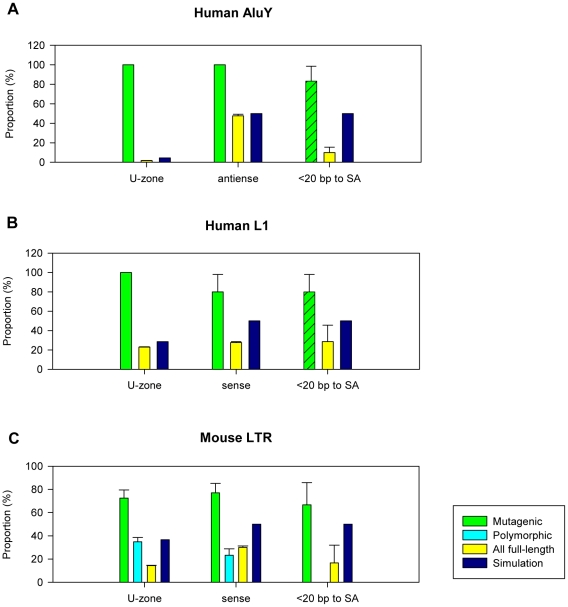
Comparisons of TE frequency within the U-zone.Three TE classes were examined and results were plotted in panel A, B, and C for the human Alu, human L1, and mouse LTR elements, respectively. In each plot, three groups of comparisons are shown: ‘U-zone’ stands for TE insertions within the U-zone; ‘antisense’ for human Alu or ‘sense’ for human L1 and mouse LTR indicates TEs within the U-zone in the corresponding orientation with respect to the enclosing gene; ‘<20 bp to SA’ indicates TE insertions within 20 bp of SA sites with an exception for human Alu and L1 mutagenic TEs (marked by shading), for which all cases were included due to limited total numbers. The y-axis shows the percentage of TEs that belong to the corresponding groups. Bars in each group represent mutagenic TE insertions (green), polymorphic TE insertions (light blue), all full-length TE insertions in the reference genome (yellow), and computational simulation as a random control (dark blue). Error bars represent standard errors derived from the total number of cases (sample size) for each category.